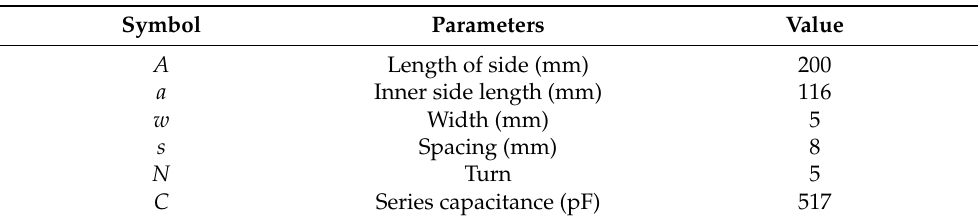
Figure 5. ( a ) The structure diagram of the MM unit cell. The relationship of relative permeability and resonance frequency depending on ( b ) the number of turns, ( c ) the width and ( d ) the spacing. Table 2. Parameters of the MM unit cell. Table 2. Parameters of the MM unit cell.